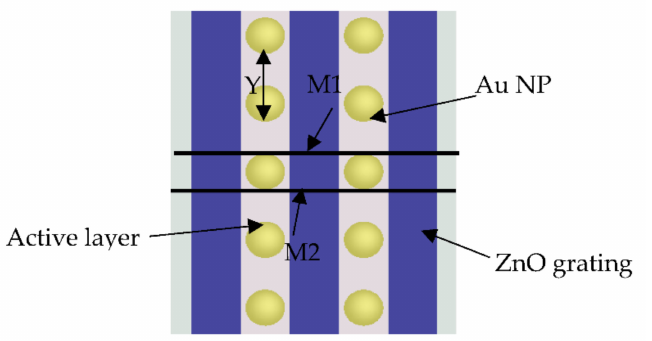
Figure 9. Top view of the proposed structure illustrates the location of monitors M 1 and M 2. The distribution of optical power illustrates that the HTL gratings absorbed the inci- dent optical power and retransmitted it to the active layer before being collected by ZnO gratings, as shown in Figure 10a. On the other hand, more optical power was absorbed by the proposed structure in the HTL gratings and retransmitted to the active layer, which re- ceived more power by the AuNPs before retransmitting the power to the ETL, as illustrated in Figure 10b.